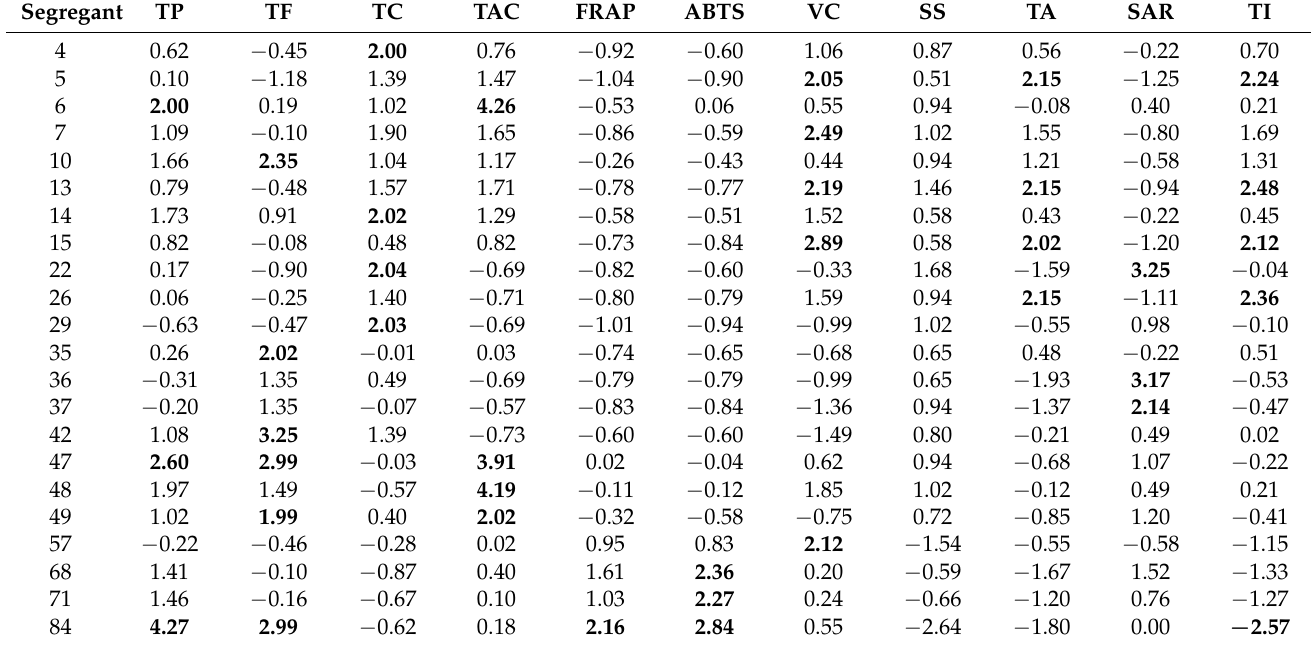
Table 4. Z Score values for the fruit chemical traits in the tree tomato breeding population. Bold indicates values ≥ 2.